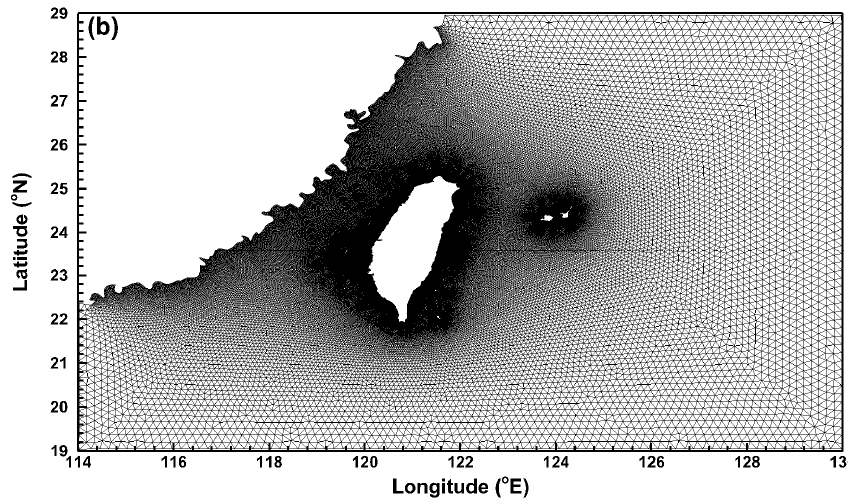
Figure 1. ( a ) Bathymetry and ( b ) unstructured grids for the computational domain.